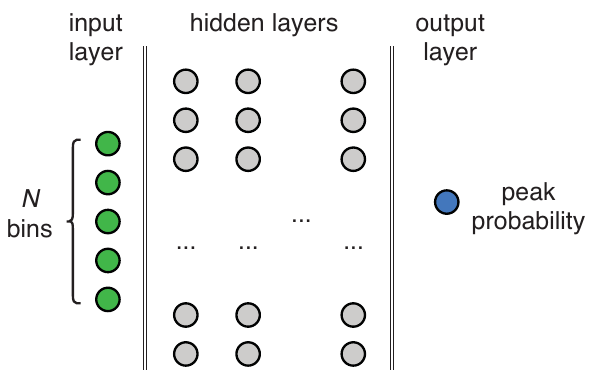
Figure 2: The architecture of the neural network used for peak finding. It consists of N input nodes varying between 5 to 21 in odd numbers (so the peak is always at the centre index), 6 hidden layers of varying number of perceptrons, and a single output perceptron indicating the peak probability.